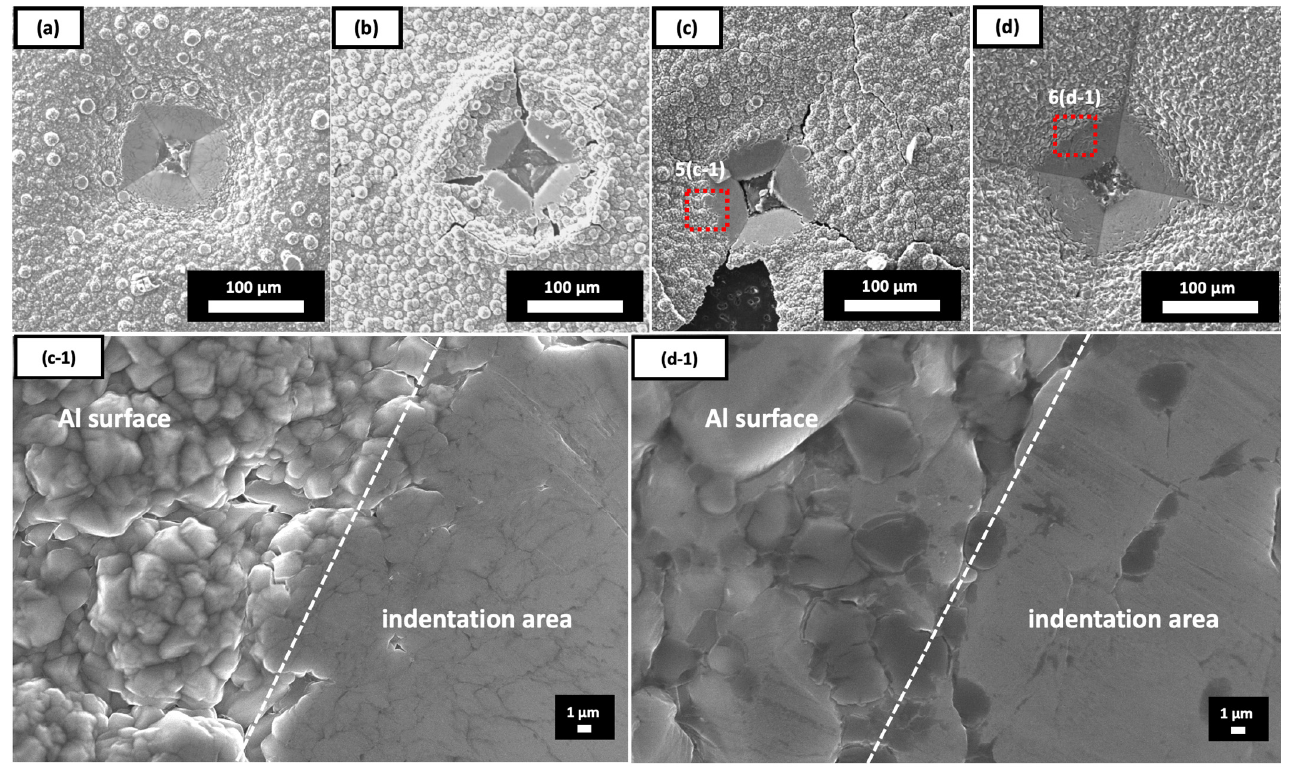
Figure 5. Indentation morphologies observations: ( a ): dAl-2; ( b ): dAl-3; ( c ): dAl-5; ( d ): dAl-6 by SEM; ( c-1 ) and ( d-1 ) are the enlarged observation of ( c ) and ( d ) separately.